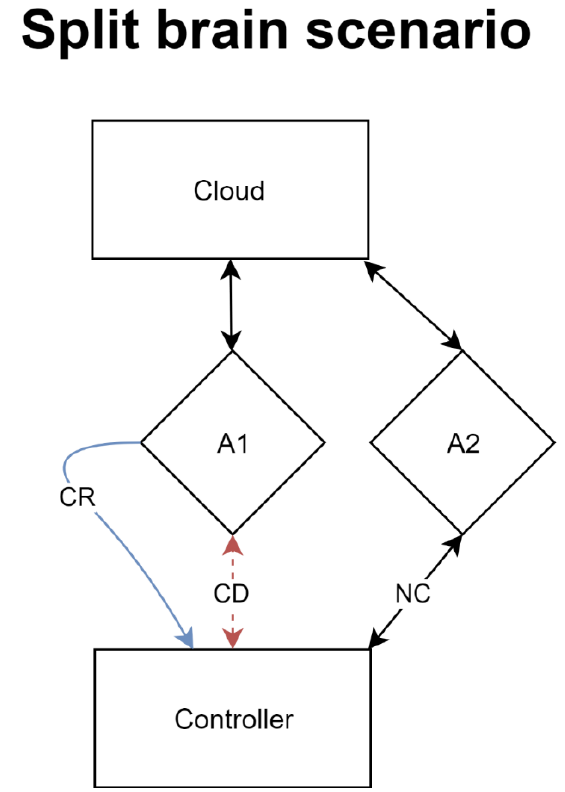
Figure 3. Split brain scenario where a connection is dropped from only one side.